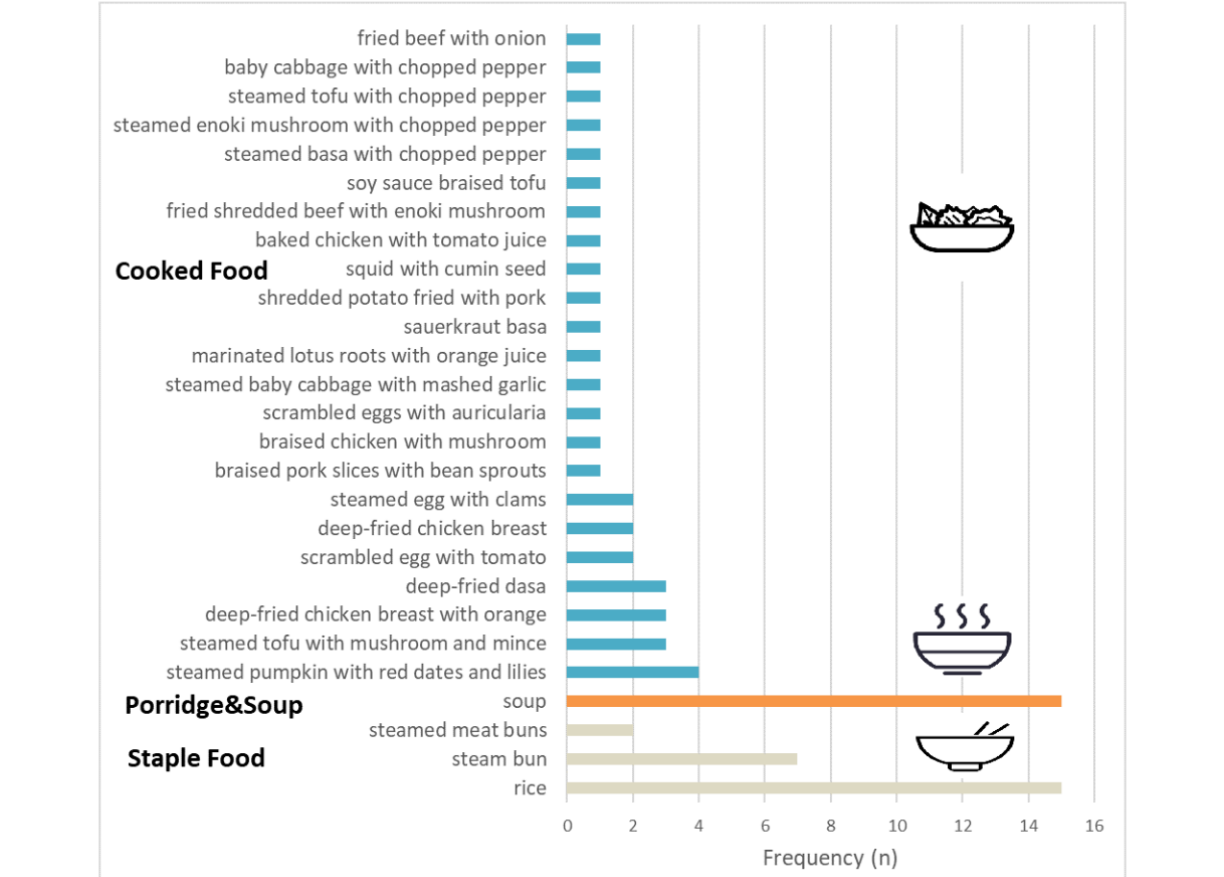
Figure 5. Example of system output: frequency of foods consumed by 1 sample